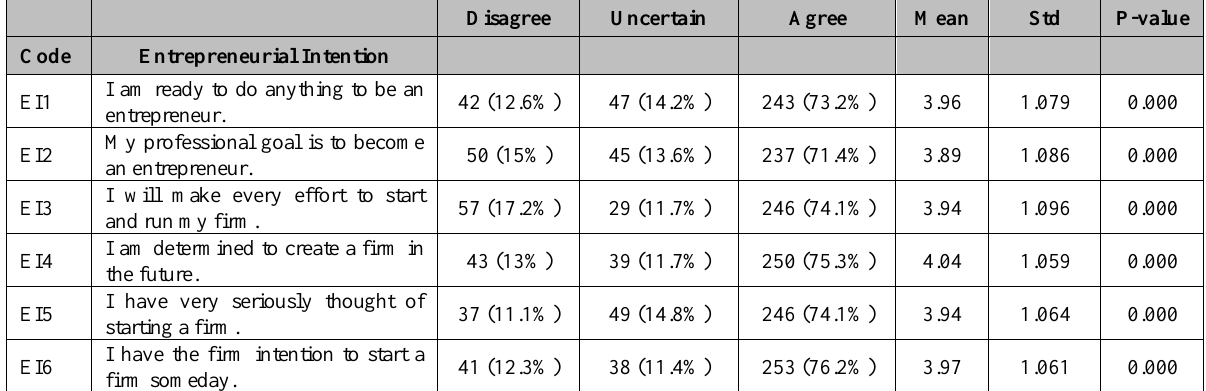
Table 7. Frequency Distribution of Entrepreneurial